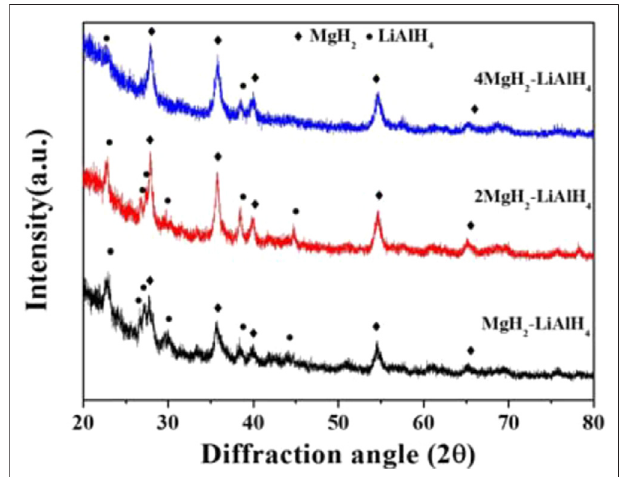
FIGURE 4 | XRD patterns of different ratios of MgH 2 and LiAlH 4 in the Mg – Li – Al system after the milling process (Lin & Tsai,